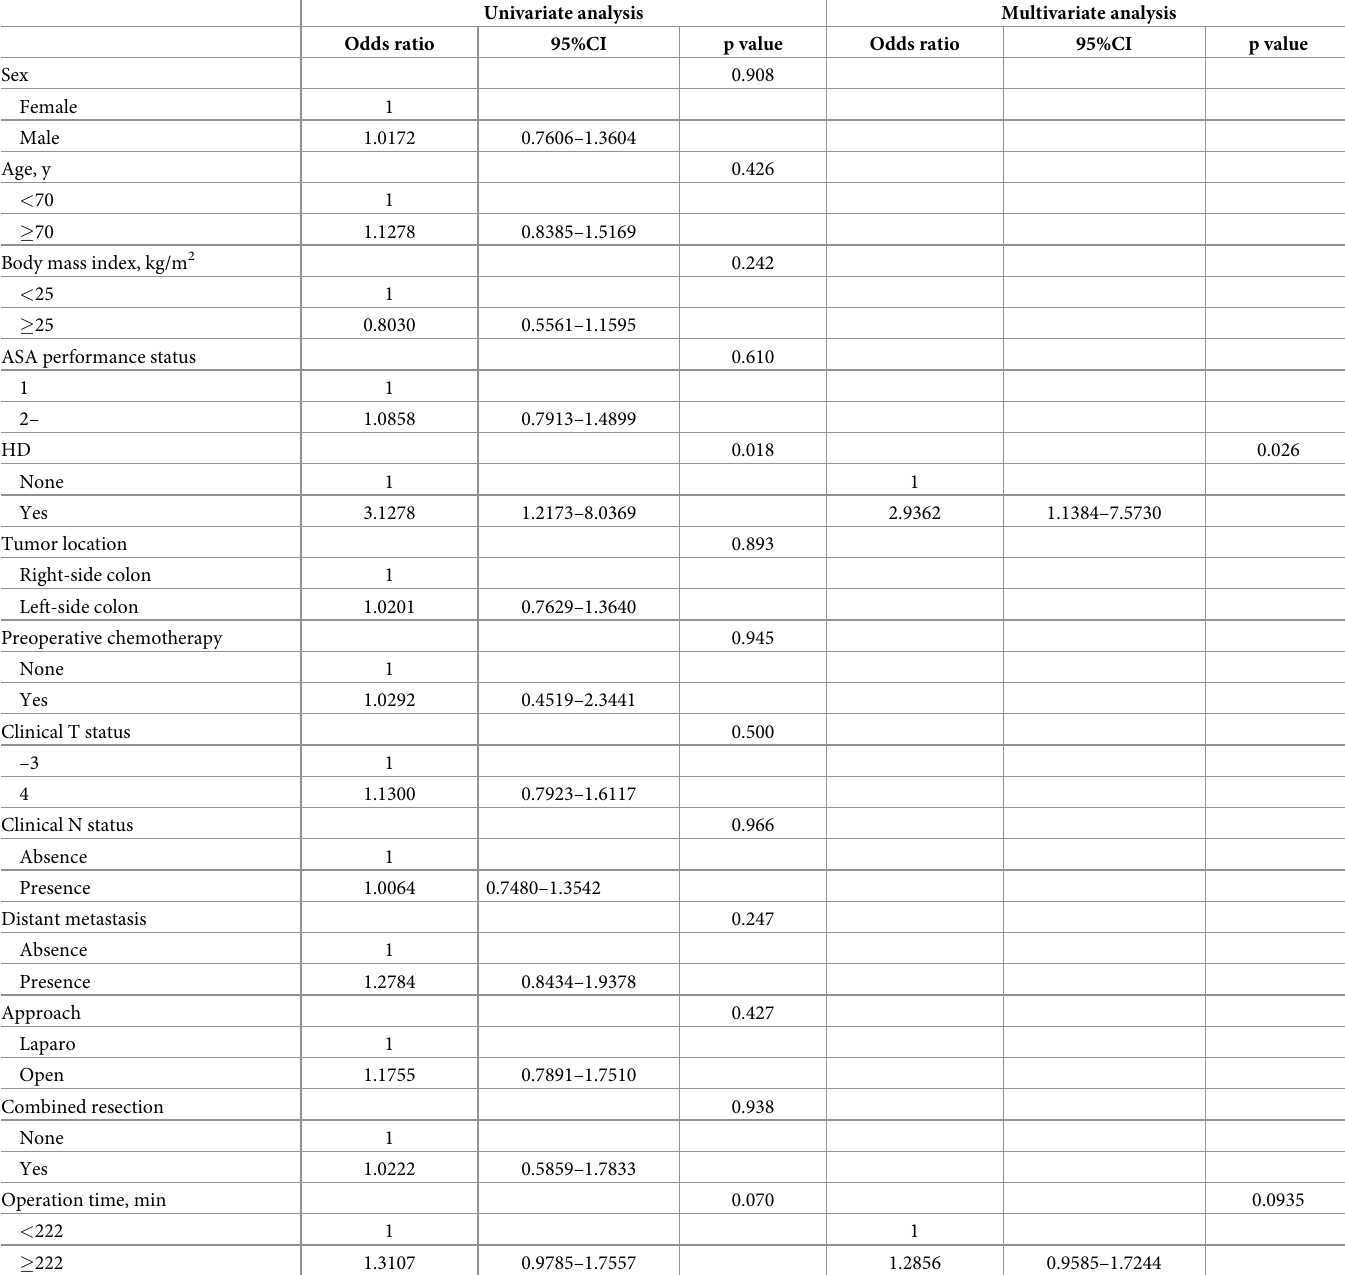
Table 4. Clinicopathological factors predicting postoperative complications in colon cancer